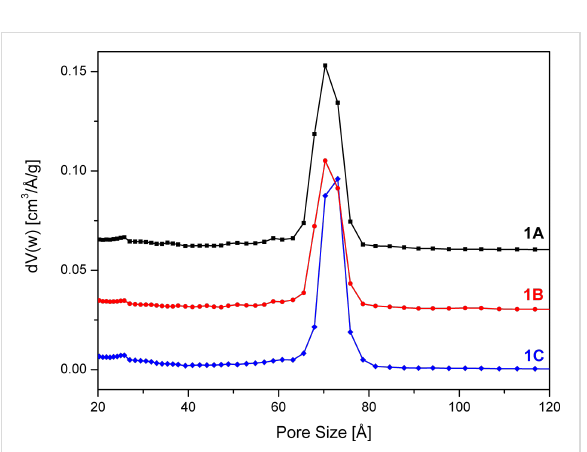
Figure 2: NLDFT pore size distributions of SBA-15 unwashed ( 1A ), after washing with 30 mL ethanol ( 1B ) and 30 mL water ( 1C ) calcu- lated from the adsorption branch of the isotherm. The pore size distrib- utions are offset by 0.06 ( 1A ) and 0.03 ( 1B ) cm 3 /Å/g.